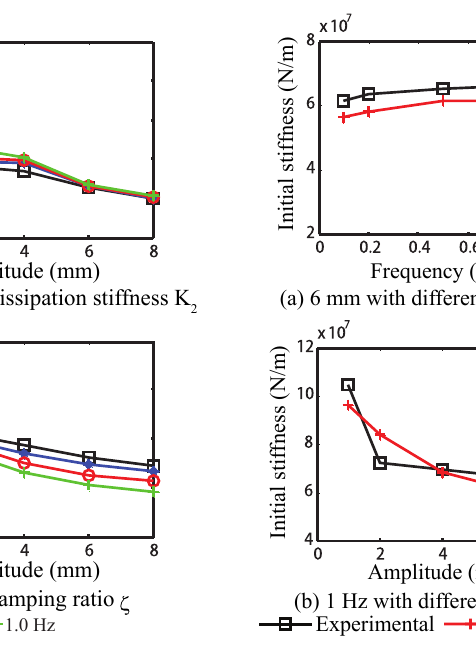
Fig. 10. Amplitude’s effect on characteristic parameters of the device. Fig. 11. Comparison of initial stiffness be- tween experimental and numerical